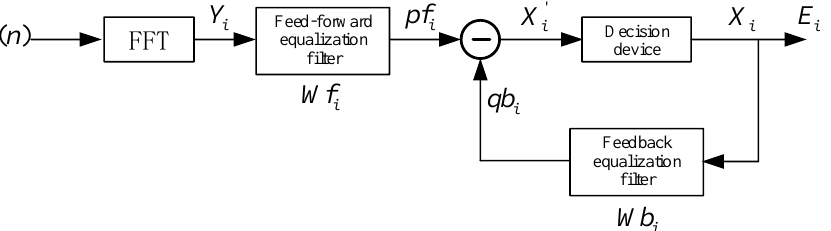
Figure 2. OFDM-based frequency domain decision feedback adaptive equalization algorithm.